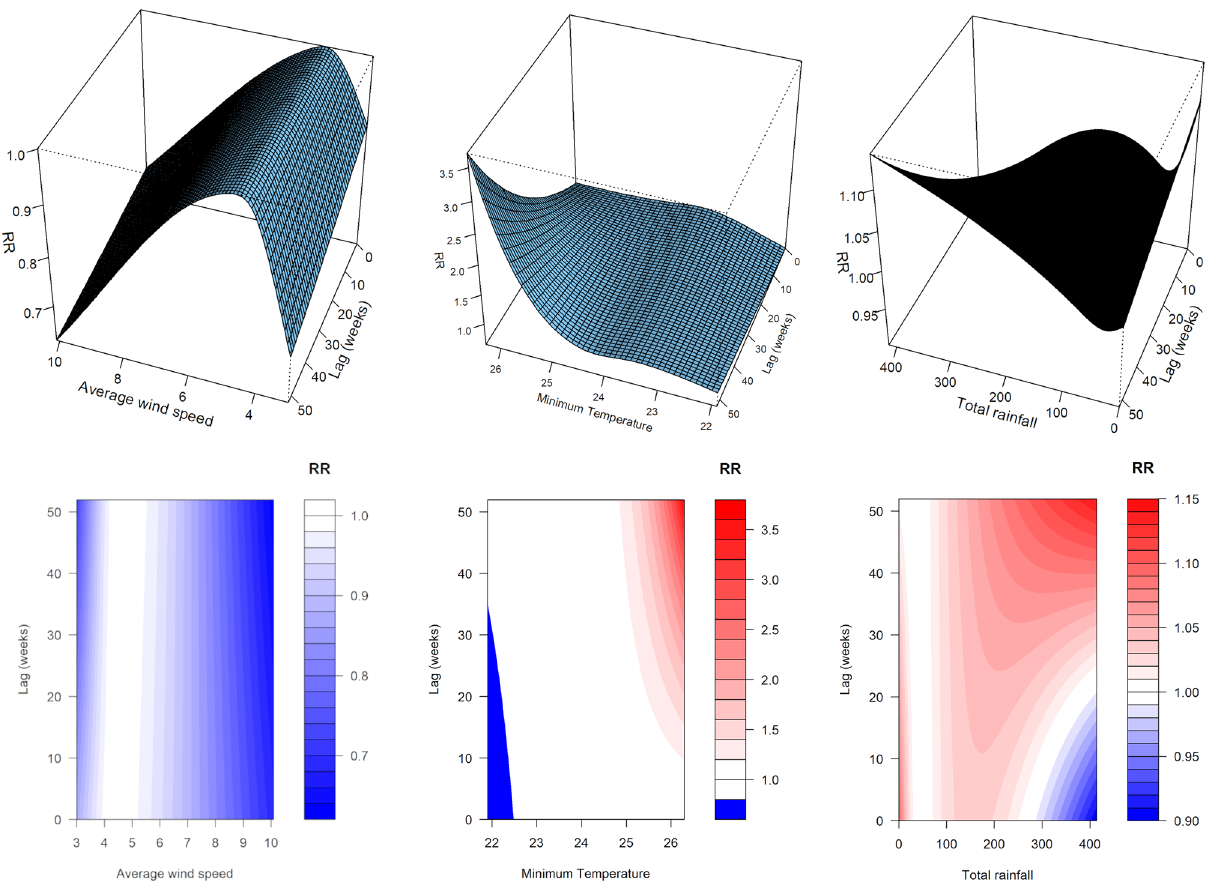
Figure 2. Three-dimensional exposure-lag-response curves (top) and corresponding contour plots (bottom) from final model, for (left to right) average wind speed, minimum temperature and total